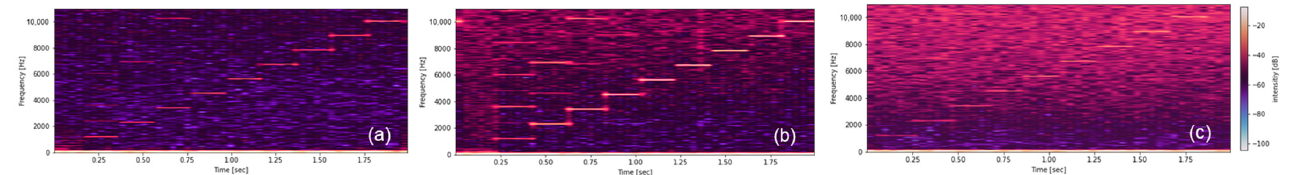
Figure 6. Laser-induced vibrational spectrogram of agarose with Young’s moduli of ( a ) 0.042 MPa, ( b ) 0.76 MPa, and ( c ) 2.3 MPa.